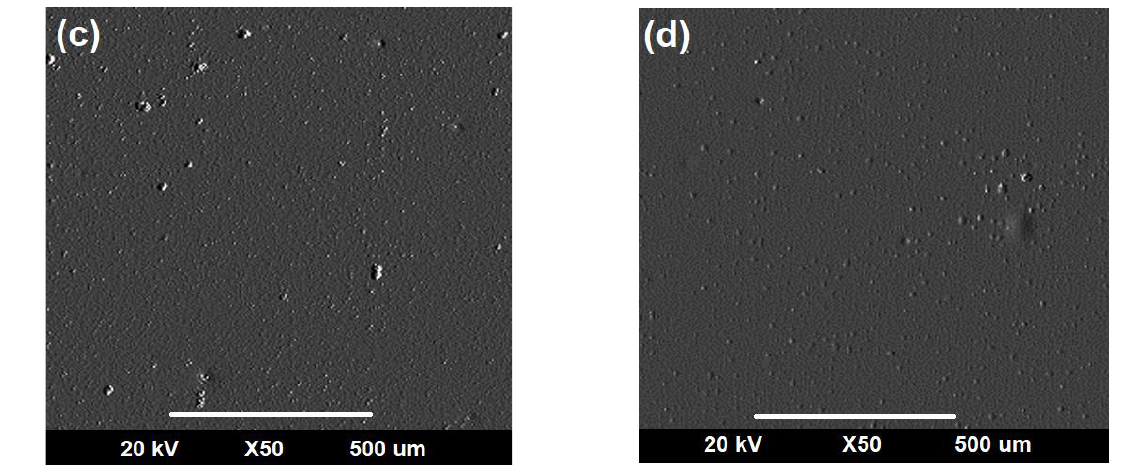
Figure 14. SEM micrographs after 60° impact angle corro-erosive testing for coatings ( a ) TaC, ( b ) HfC, ( c ) (Ta 70 -Hf 30 -C) and ( d ) (Ta 30 -Hf 70 -C).